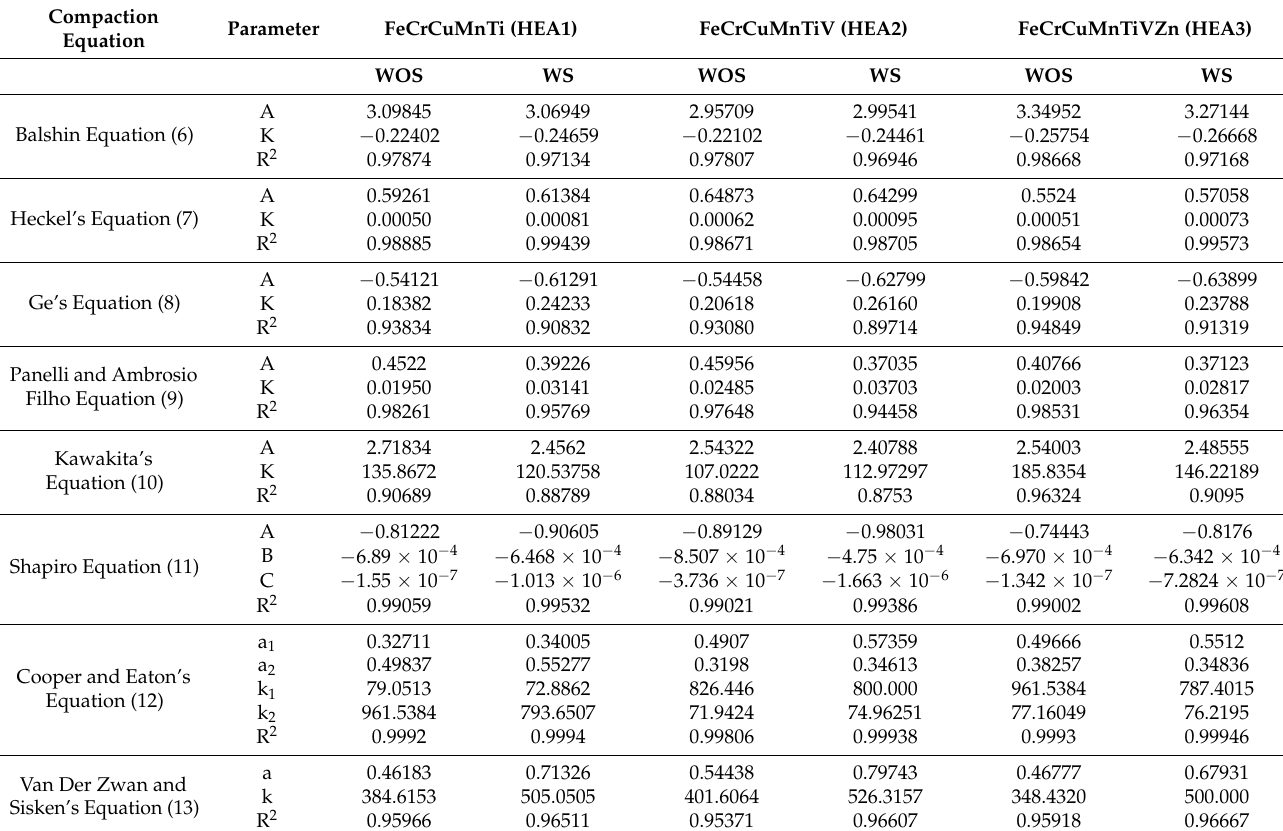
Table 5. Various parameters associated with the linear and non-linear compaction equations obtained for quinary thermoelectric compacts. Compaction